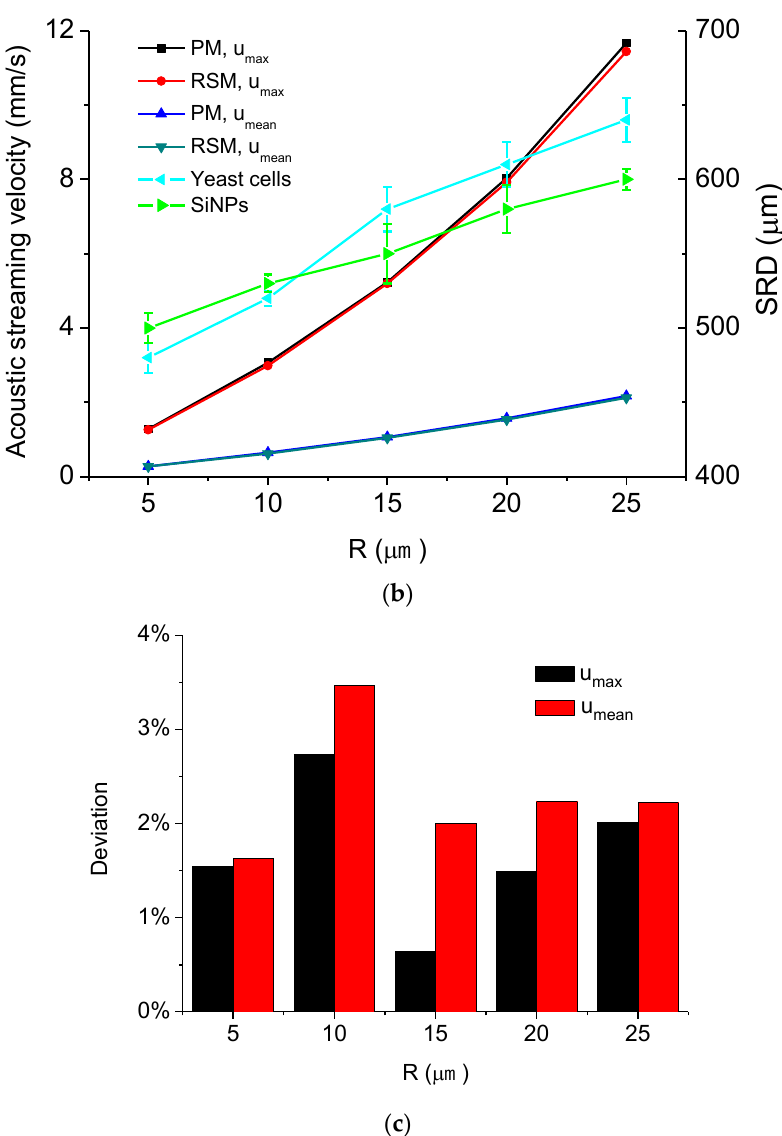
Figure 8. ( a ) Computed acoustic streaming velocity distribution along the r direction at the droplet-substrate interface in the ultrasonic probe-droplet-substrate system under different R . ( b ) u max , u mean and SRD versus R in the ultrasonic probe-droplet-substrate system. ( c ) Deviations of u max and u mean computed by the PM and RSM versus R in the ultrasonic probe-droplet-substrate system. The dependency of acoustic streaming velocity on the length of the MMP L is shown in Figure 9. Figure 9a shows the distribution of acoustic streaming velocity along the r direction at the droplet-substrate interface computed by the PM and RSM under different L , from which it is seen that the distribution of acoustic streaming velocity changes little when L varies. Figure 9b shows u max , u mean and experimentally measured SRD of the cleaned area for yeast cells and SiNPs versus L , from which it is seen that u max , u mean and the SRD change little when L changes. This is because that the vibration of the MMP’s portion outside the droplet does not affect the acoustofluidic field within the droplet (Figures 1a and 3a). As a result, it can be known that L has little influence on the removal effect of micro/nanoscale particles at the droplet-substrate interface in this system. Figure 9c shows D of u max and D of u mean versus L , respectively, and it is seen that D of u max is in the range of 0.6% to 1.8%, while D of u mean is in the range of 1.9% to 2.9%.